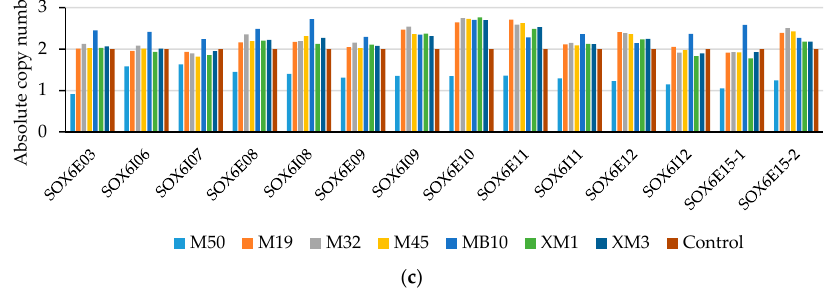
Figure 2. The CNVplex ® assay result for SOX6 (CNP13). The different colors represent the individual’ absolute copy number of SOX6 in the different positions in the CNP13. There are two XH individuals with absolute copy values in exons 10 and 11 of SOX 6 of about 2.6 (CN = 3) (sample ID 51 and 66 shown in ( a ), which consist with XM1, XM3 in ( c )); others were normal individuals (CN = 2). In WRR chickens, there is a single individual with absolute copy number less than 1.2 (CN = 1) (sample ID 81 shown in ( b ), which consists with M50 in ( c )), and four individuals with an absolute copy values in exons 10 and 11 of SOX6 greater than 2.5 (CN = 3) (sample ID 55, 66, 76 and 90 shown in ( b ), which consist with M19, M32, M45 and MB10 in ( c ),